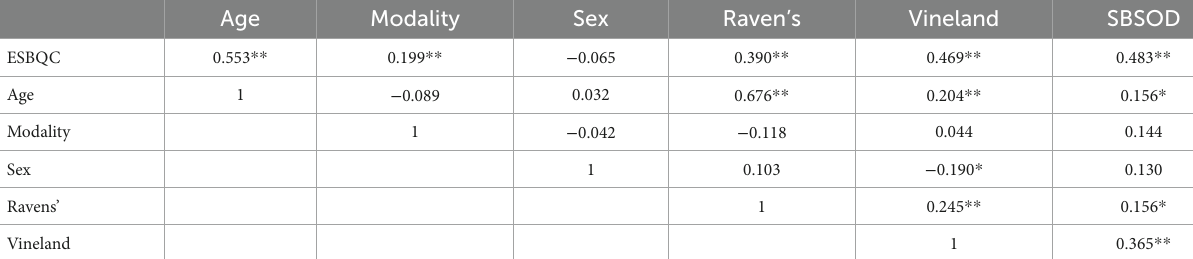
TABLE 3 Pearson correlations between variables (sample sizes varied from 162 to 174).